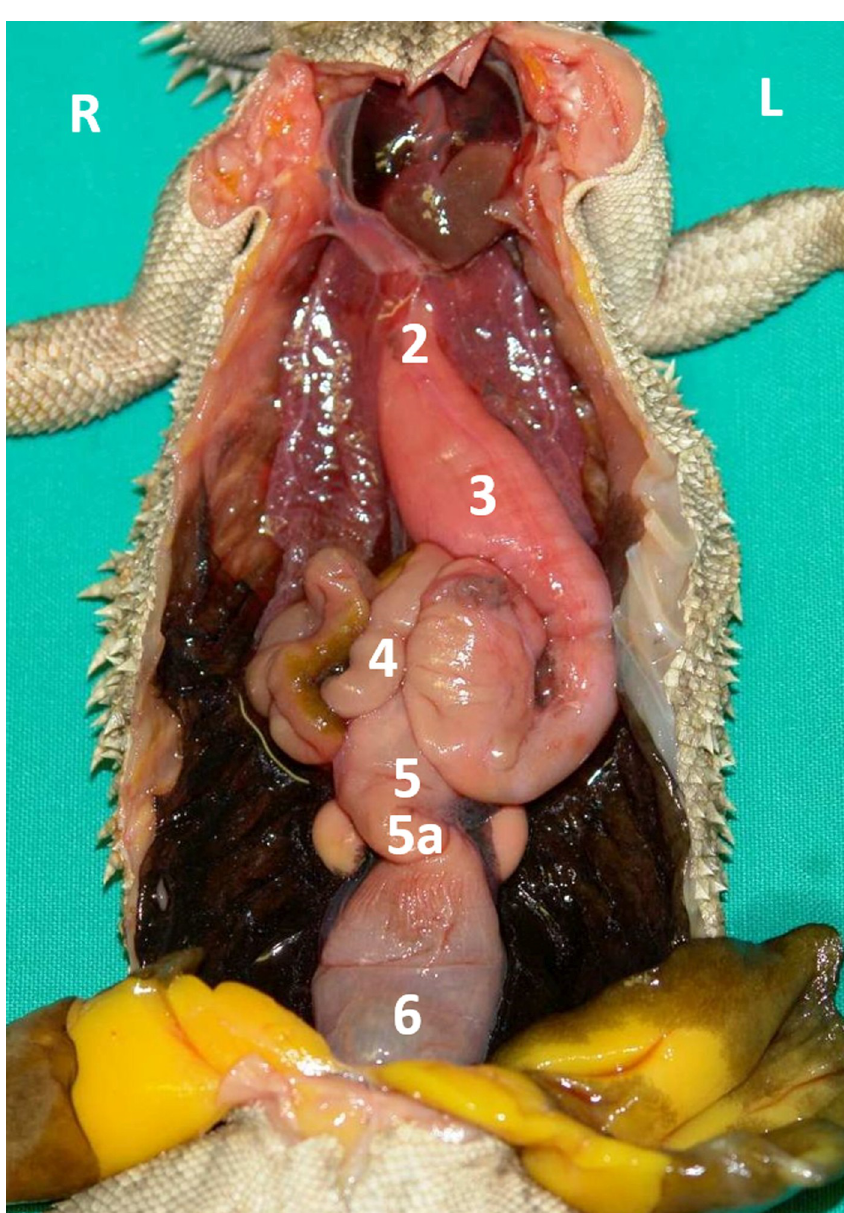
Fig 2. Topography of the alimentary canal of a male bearded dragon in situ, ventral view. Ventral skin, muscles, skeleton, and serosa removed; pericardium opened ventrally and partially removed; and fat bodies distracted caudolaterally to expose the esophagus (2), stomach (3), small intestine (4), ampulla coli (5), isthmus coli (5), and rectum (6). can be found on either the left or right side of the coelom. Most of the small intestine is located in the caudal half of the coelom; however, if there are a large number of follicles or eggs in the salpinx or pronounced fat bodies, the small intestine may be displaced into the cranial- half of the coelom. The lining of the small intestine is comprised of longitudinal folds, which vary in height. There are three defined sections of the small intestine (Fig 1A/4 and 2/4), the duode- num, jejunum, and ileum. The duodenum disembogues the common bile duct and the